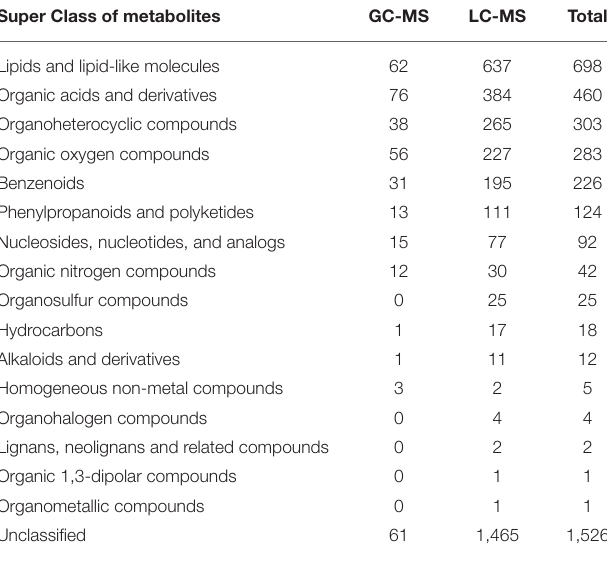
TABLE 1 | Classification statistics of identified